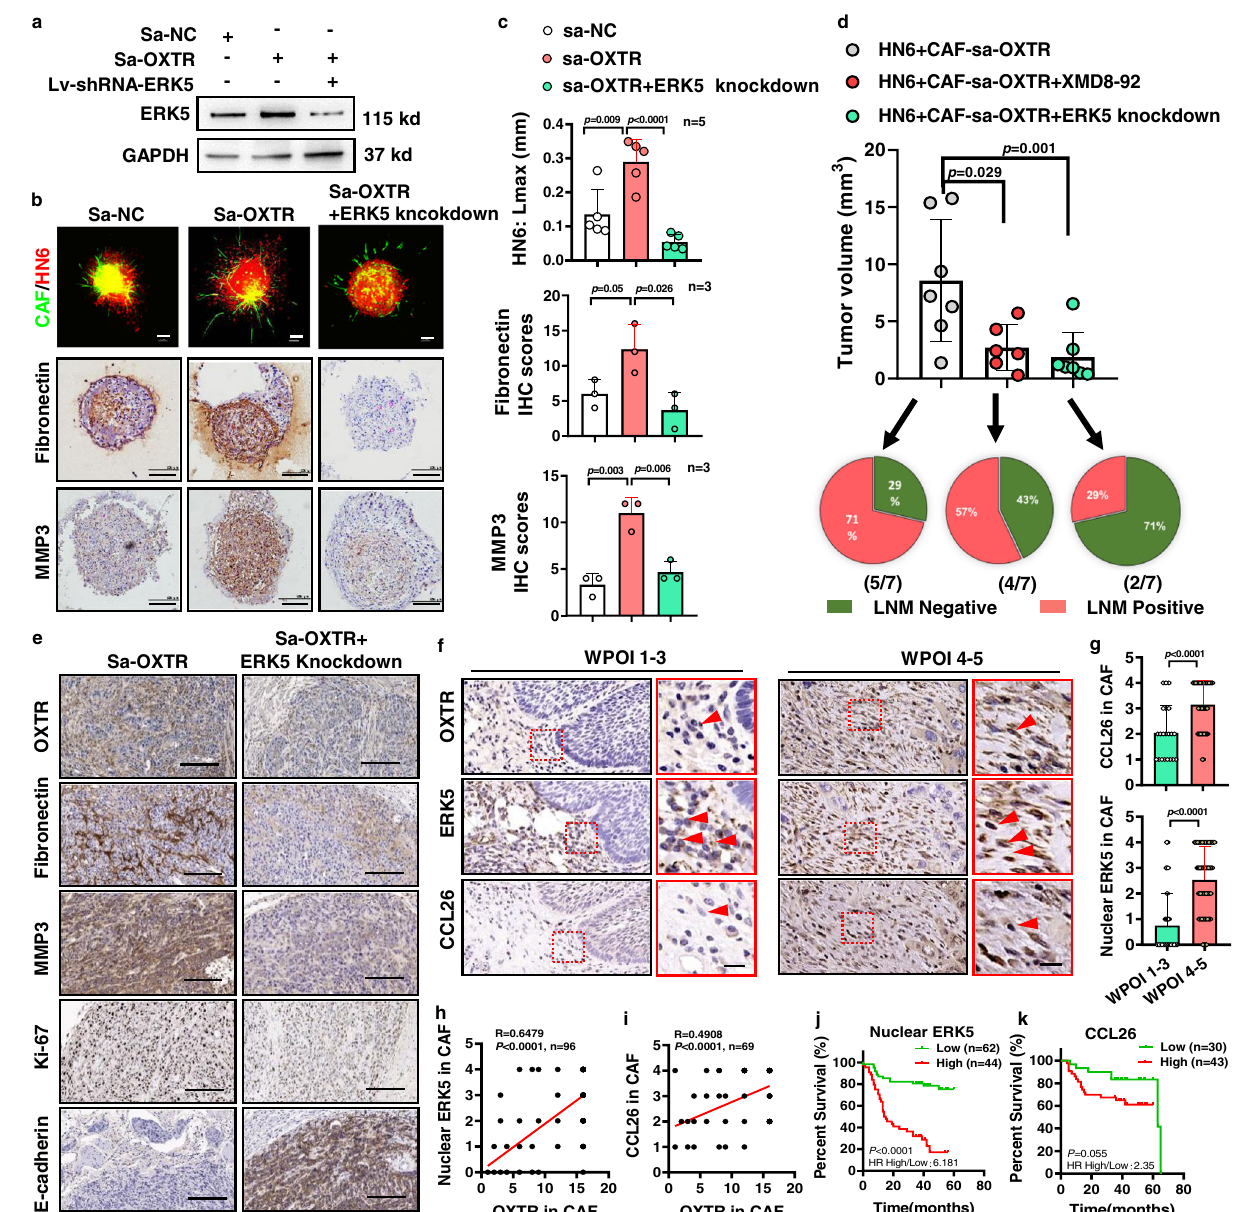
Fig. 7 | ERK5 inhibition in CAFs is capable of suppressing OSCC tumor pro- gression. a Stable knockdown of ERK5 in CAFs overexpressing OXTR (repre- sentative of n =3 biologically independent experiments) and ( b , c ) its impacts on tumor invasion, fi bronectin, and MMP3 levels. Representative images of condi- tional CAFs (green) co-cultured with HN6 (red) to form heterotypic spheroids embedded in conditional 3D collagen matrix for organoid invasion studies ( n =5 biologically independent samples). Spheroids were then embedded in paraf fi n for histochemistry analyses by two-tailed t test ( n =3 biologically independent sam- ples). Scale bar: 100 μ m. d Graphical analysis of tongue tumor volume or LMN percentageafter2×10 5 HN6OSCCcellsweremixedwith1×10 6 sa-OXTRCAFsand injected into the tongue of 4- to 5-week-old NCG mice with either XMD8-92 treat- ment(50mg/kg,twiceaweek)orCAFswithERK5knockdown. n =7/group, P =two- tailed t test or Pearson ’ s correlation test. e Representative IHC images from OSCC